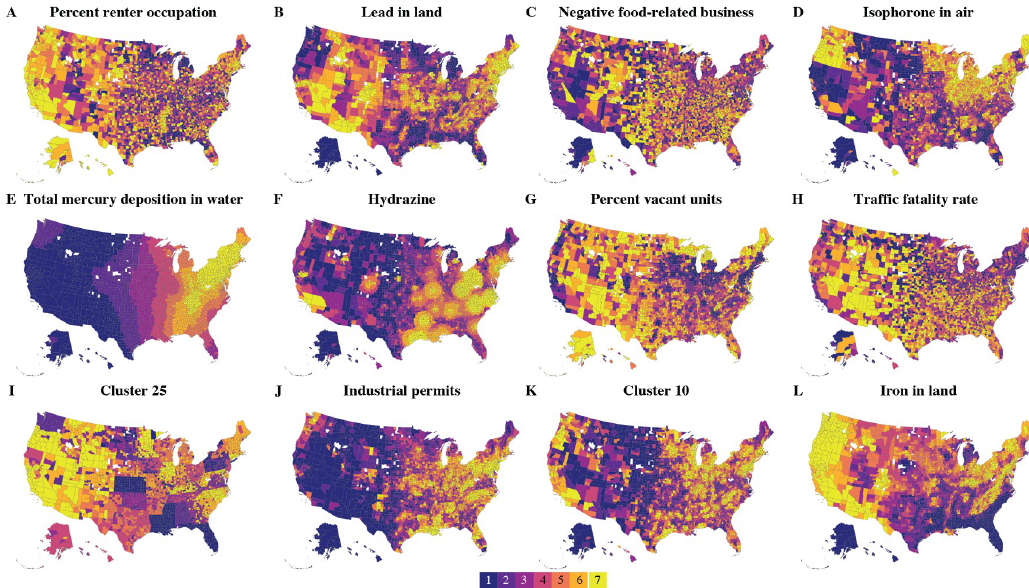
Fig 2. County-level geographical septile distribution for the first 12 statistically significant factors with at least one statistically significant coefficient ranked by decreasing Δ IC. The factors labelled A–M are the same as shown in Fig 1, Plates B– M and are ordered identically in both figures. Base map was taken from https://github.com/hrbrmstr/albersusa/blob/master/inst/ extdata/composite_us_counties.geojson.gz.